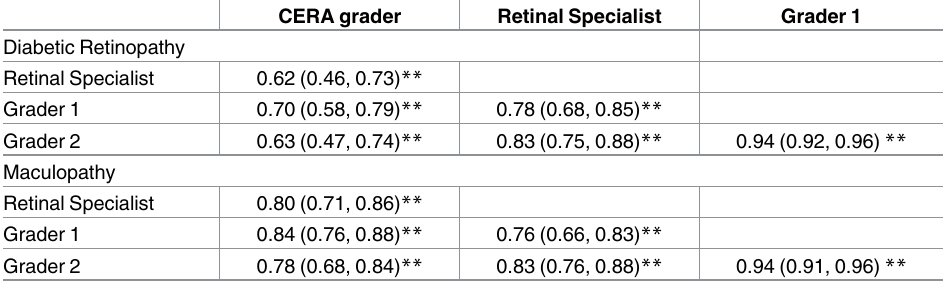
Table 7. Intra-class correlation coefficient (95% CI) among CERA grader, retinal specialist and local graders in grading DR and maculopathy before training through the test set.